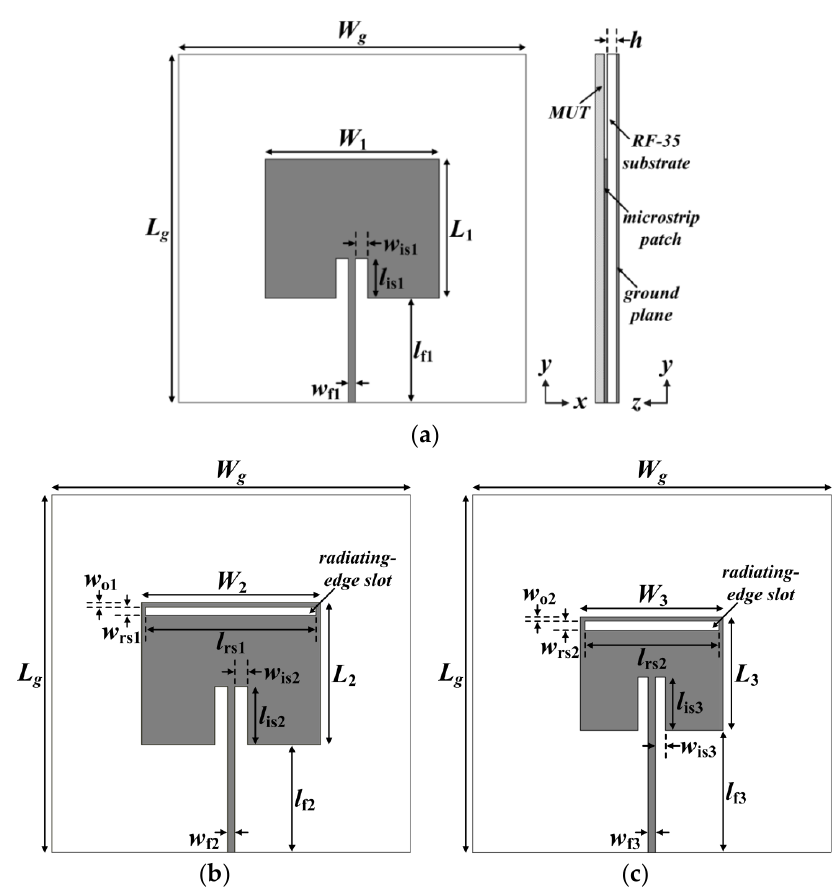
Figure 1. Geometries of microstrip patch sensor antennas: ( a ) Conventional inset-fed rectangular microstrip patch antenna; ( b ) slot-loaded rectangular microstrip patch antenna; ( c ) scaled slot-loaded rectangular microstrip patch antenna.